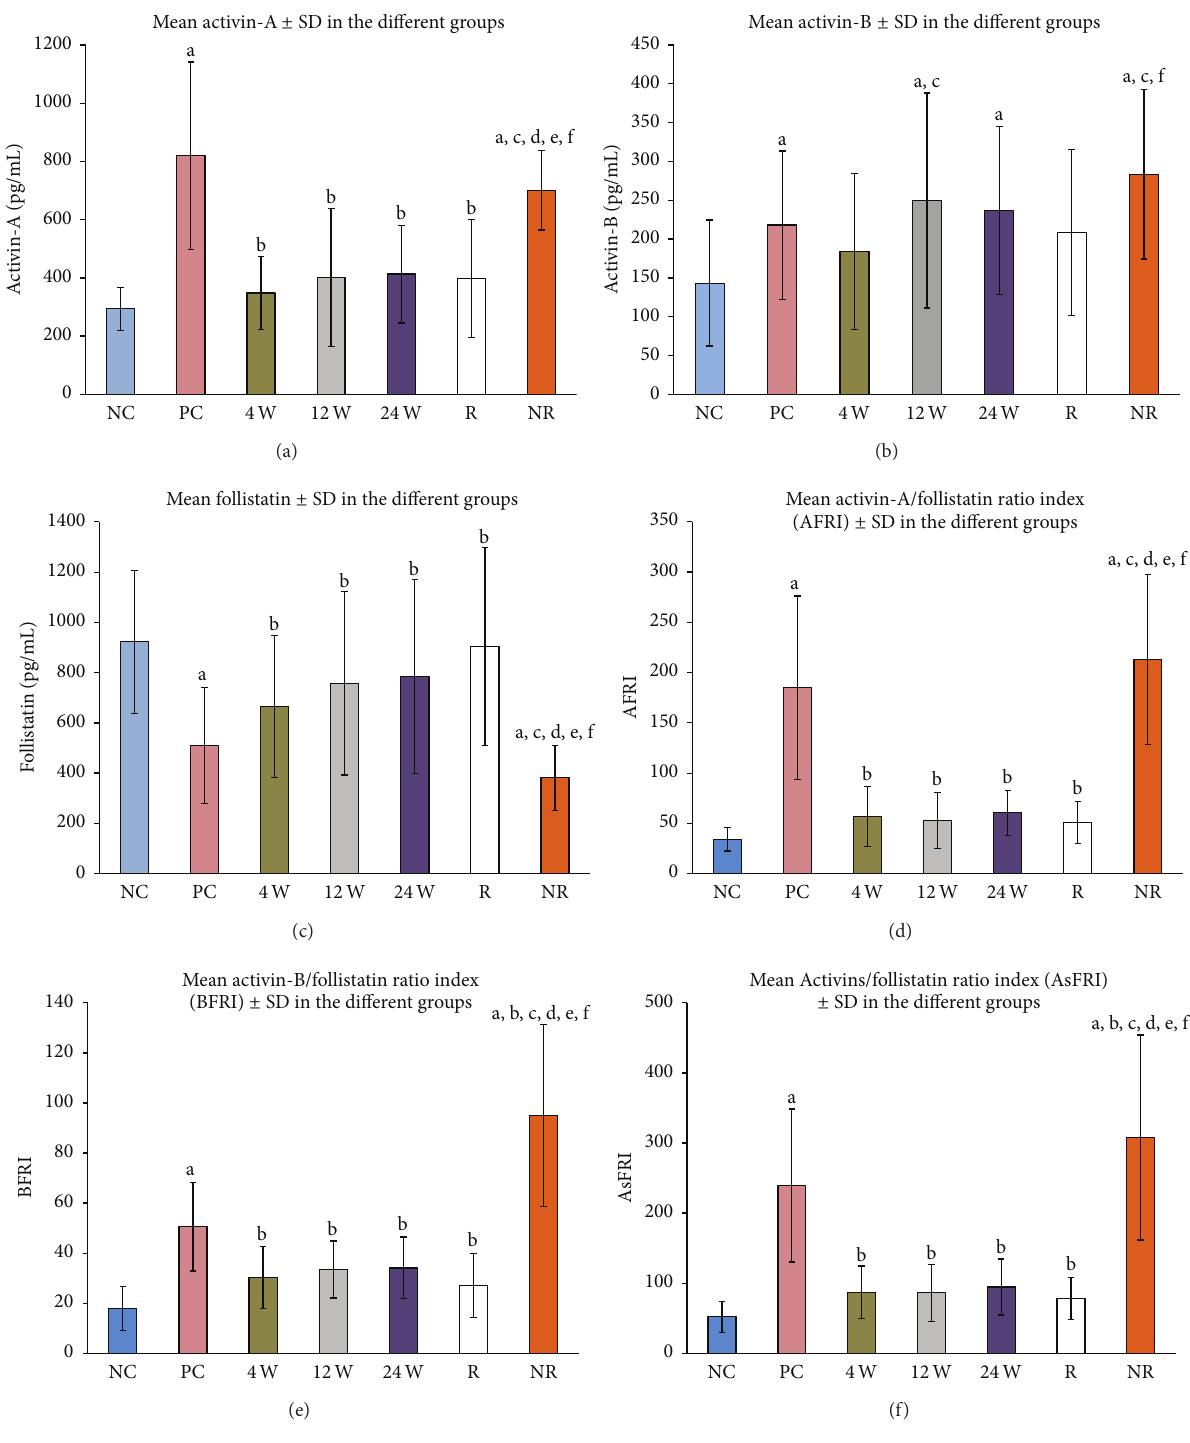
Figure 1: Mean ± SD of serum (a) activin-A, (b) activin-B, (c) follistatin, (d) AFRI, (e) BFRI, and (f) ASFRI in the different study groups ( a 𝑃 = 0.05 compared to NC, b 𝑃 < 0.05 compared to PC, c 𝑃 < 0.05 compared to 4W, d 𝑃 < 0.05 compared to 12W, e 𝑃 < 0.05 compared to 24 W, and f 𝑃 < 0.05 compared to